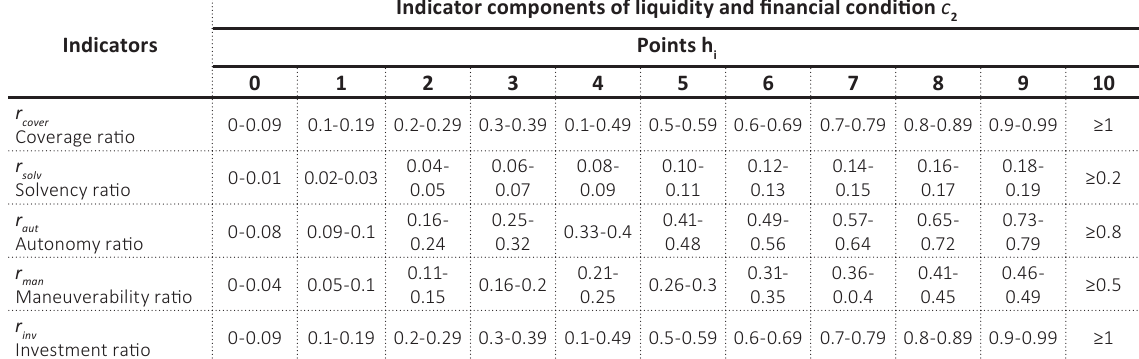
Source: Developed by the authors.